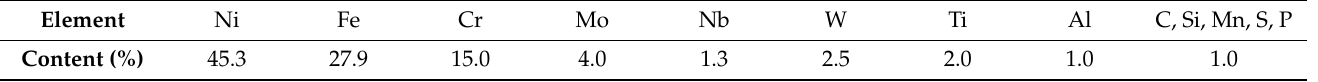
Table 1. Chemical composition of XH45MBTJuBP alloy used in the research.